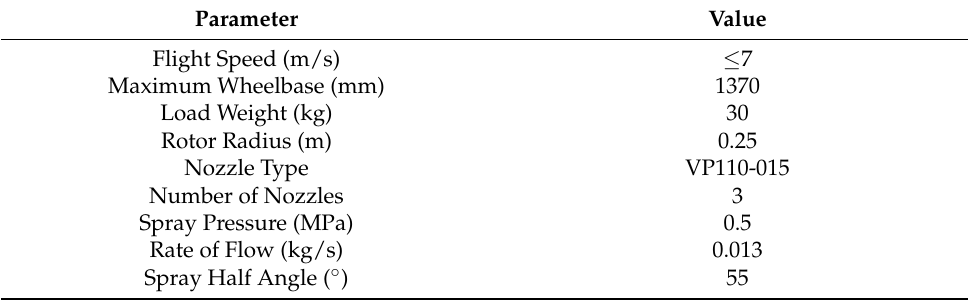
Table 1. Main parameters of the Harvest-1 plant protection UAV.